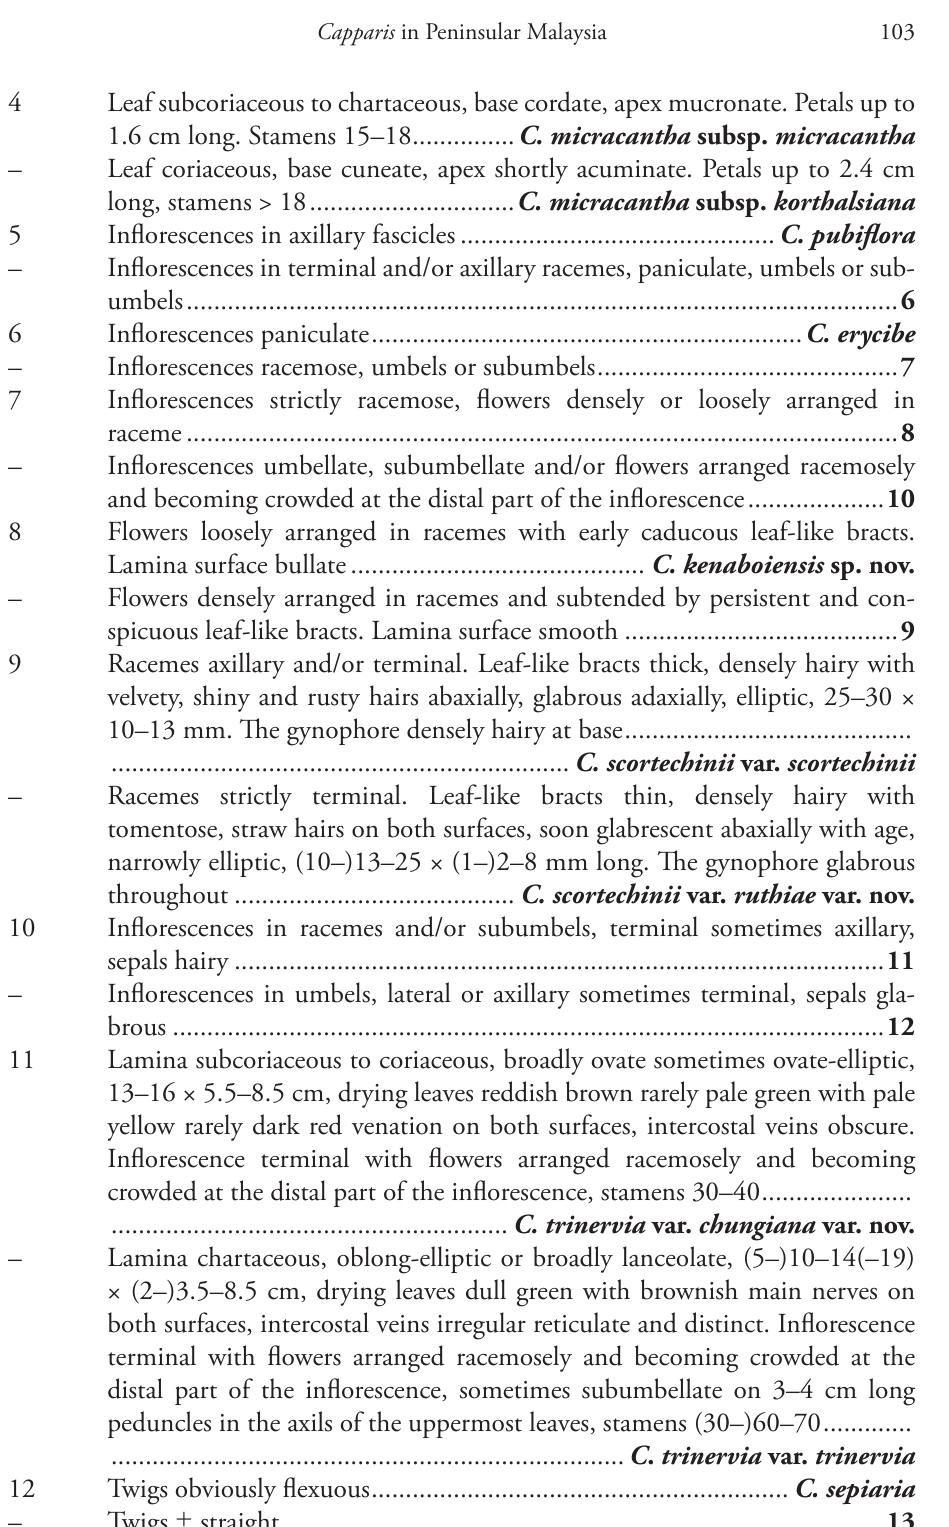
Inflorescences in terminal and/or axillary racemes, paniculate, umbels or sub-